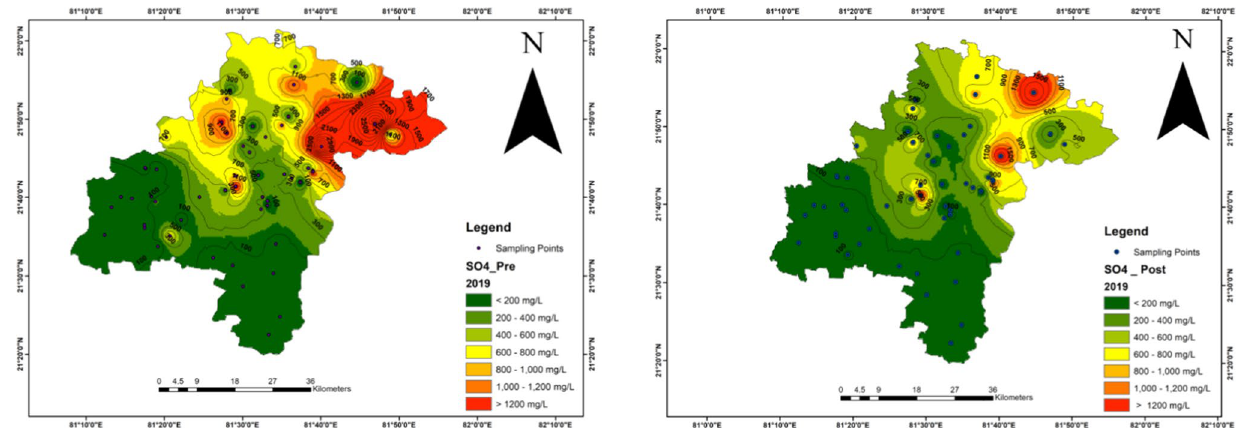
Fig. 7 Spatial distribution of SO 42− in the groundwater of the study area (pre- and post-monsoon